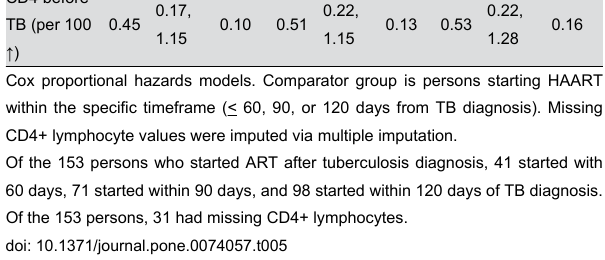
Table 4. Risk Factors for Death Among Tuberculosis Patients Surviving at Least 6 Months from Tuberculosis Diagnosis.